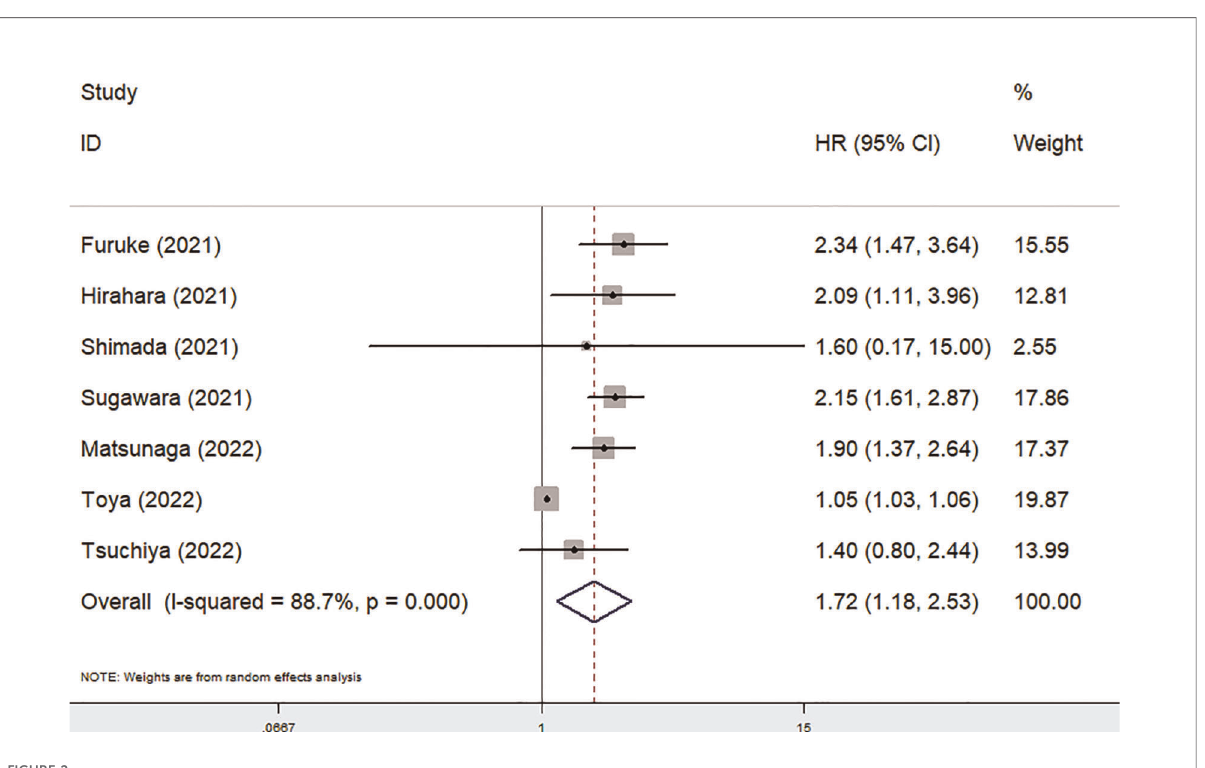
FIGURE 2 The association between preoperative geriatric nutritional risk index and overall survival of surgical gastric cancer